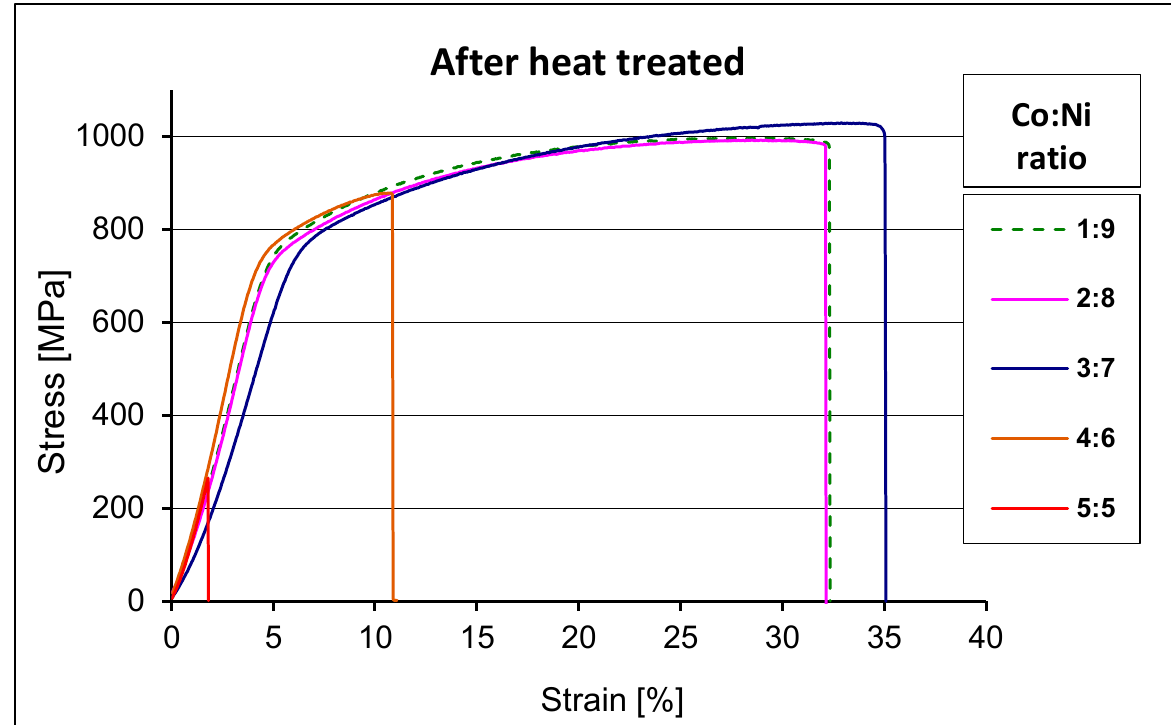
Figure 9. The stress–strain curves for all samples after heat treatments.